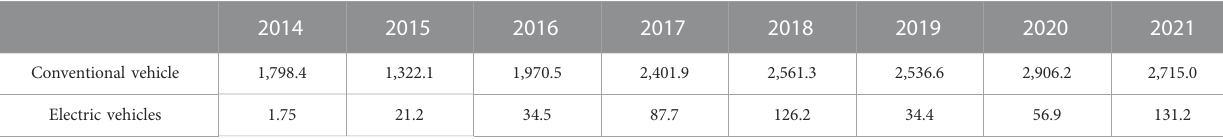
TABLE 2 Sale volume of logistics vehicles from 2014 to 2021 (unit: thousand